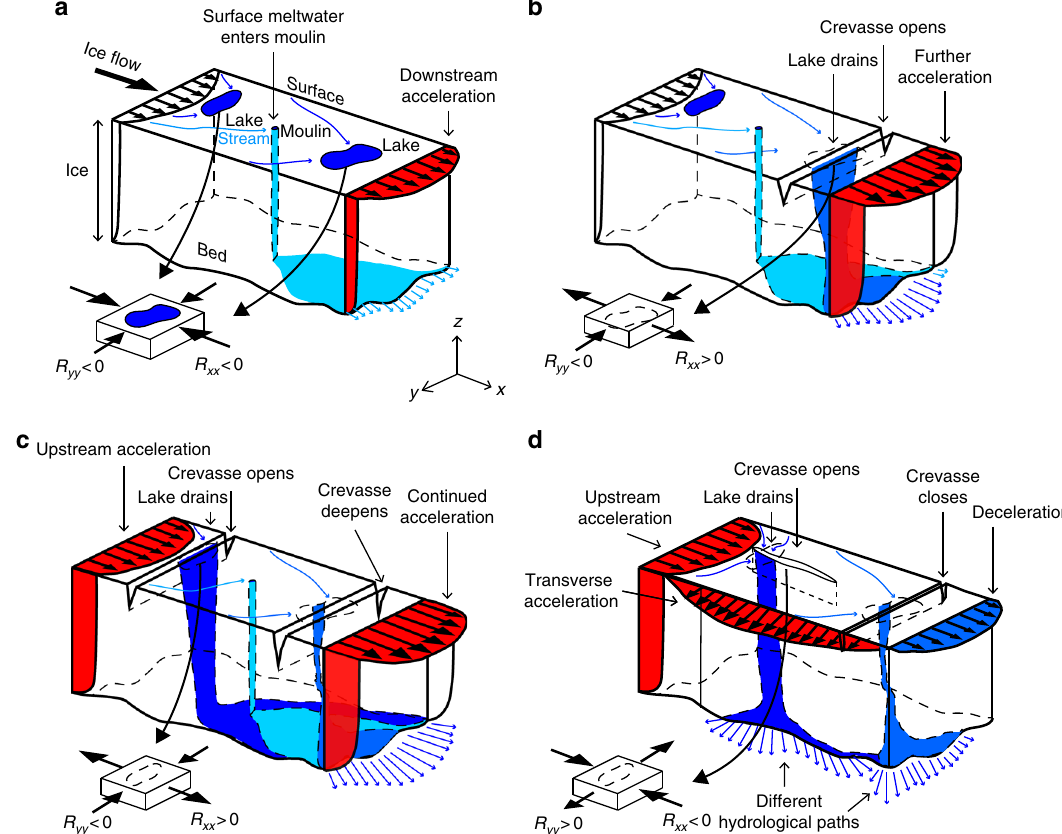
Fig. 5 Conceptual model for chain reaction drainage of supraglacial lakes. a Schematic illustration showing section of the Greenland Ice Sheet with two lakes situated in compressive ice fl ow regime (dark blue) and supraglacial melt streams feeding a moulin (light blue). Delivery of meltwater to the bed via the moulin lubricates basal motion, accelerating the downstream ice fl ow in the x direction. b A crevasse opens up in the y direction because extensional stresses ( R xx > 0) have developed at the surface, triggering a rapid lake drainage event. Additional meltwater injected at the bed accelerates the ice fl ow further. c Lake above the initial perturbation drain because sustained basal lubrication has activated the membrane stress, causing expansion of the extensional ice fl ow ( R xx > 0) at higher elevations, here illustrated with the opening of a new crevasse in the y direction. With tensile stresses growing in both extent and magnitude, a network of draining lakes expands upstream as well as downstream. d An alternative scenario in which water is routed in different direction at the bed, causing ice fl ow acceleration in the y direction. In this case, extensional stresses develop in the transverse direction ( R yy > 0), which means that the crevasse beneath the higher lake opens in the x direction, i.e. parallel to the main ice- fl ow direction. The lower crevasse closes because upstream acceleration has caused compression in the x direction ( R xx < 0). If acceleration occurs in both directions, crevasses may form transverse as well as parallel to the ice fl ow direction (not